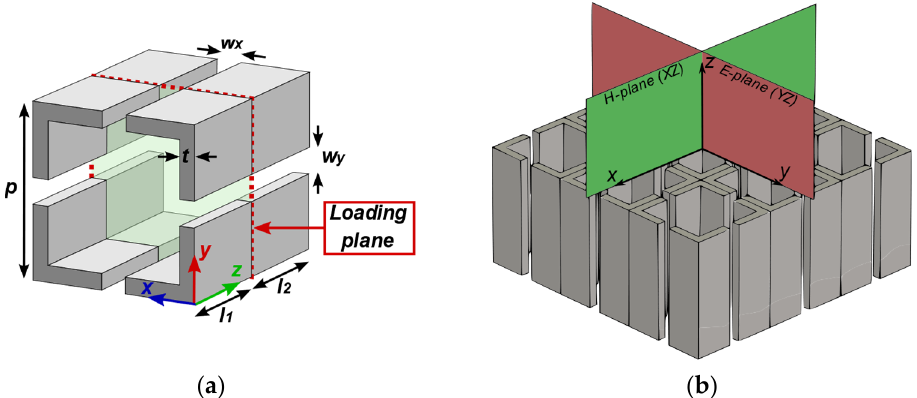
Figure 1. TEM unit-cell: ( a ) general structure, ( b ) incidence planes considering Y polarization.